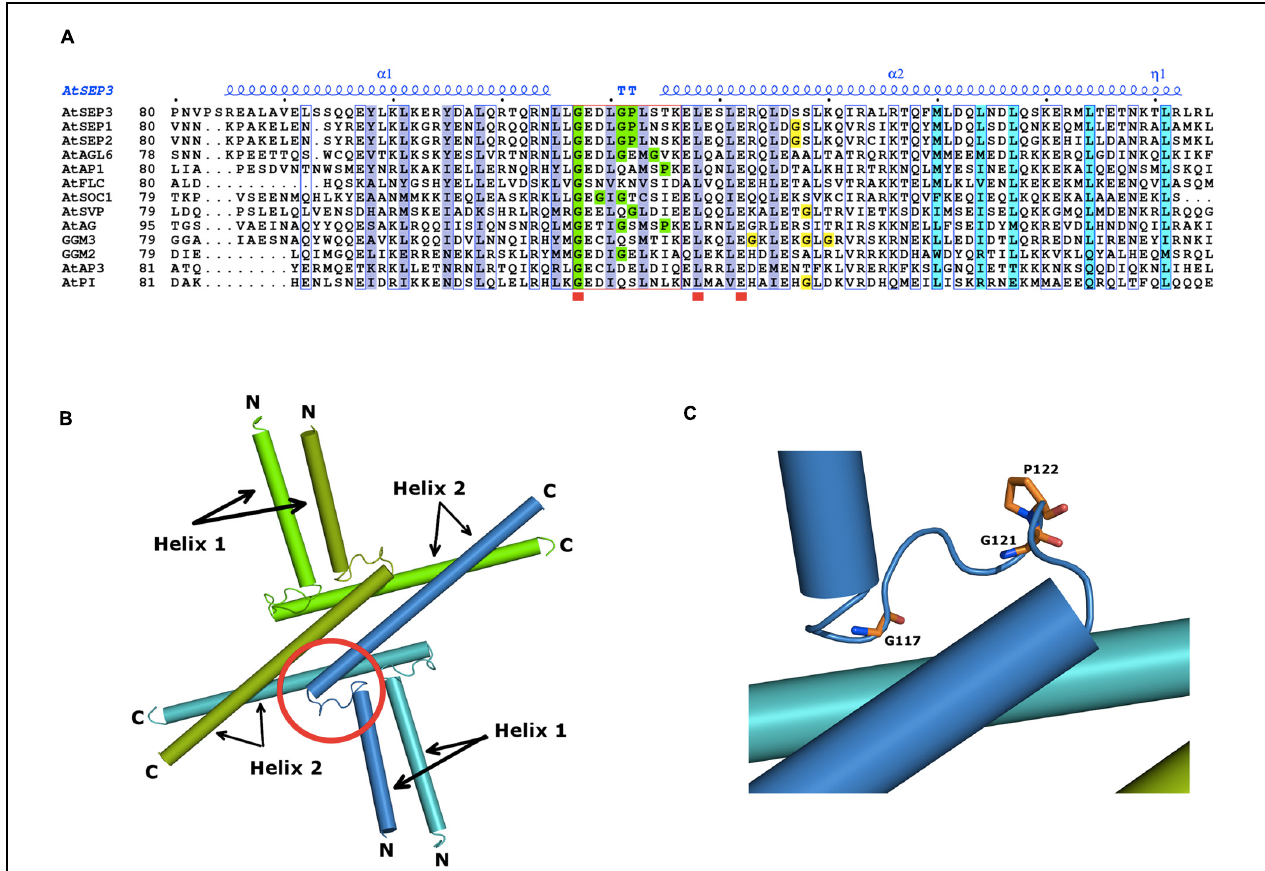
FIGURE 5 | MADS TFs oligomerisation domain. (A) Sequence alignment spanning the SEP3 crystallographic structure (PDB 4OX0). All sequences are from A. thaliana SEP3, SEP1, SEP2, AP3, PI, AP1, AG, AGL6, SOC1, SVP, and FLC and the gymnosperm G. gnemon GGM2 and GGM3 proteins. Numbering is indicated at the start of the sequences and every tenth residue indicated by a black dot above the SEP3 sequence. Highly conserved regions are boxed in blue with a white background; strictly conserved residues are depicted by a red square below the sequence. The secondary structure elements of AtSEP3 K-domain (PDB 4OX0), are shown in blue above the sequences ( α ; TT; η ). Residues involved in dimerisation and tetramerisation in SEP3 K-domain structure are highlighted in violet and cyan, respectively. The kink region between helices 1 and 2 is framed in red; Gly and Pro residues present within the kink regions are highlighted in green; Gly residues in the N-terminal region of helix 2 are highlighted in yellow. (B) Structure of SEP3 K-domain (PDB 4OX0). The oligomerisation domains of SEP3 are represented as cylinders; each monomer, composed of two distinct helices (helices 1 and 2), is colored uniquely in green, dark green, blue, and light blue. N and C-terminal regions are indicated. (C) Close-up of the SEP3 kink between helices. Glycine and proline residues are depicted as sticks colored by atom with carbons in